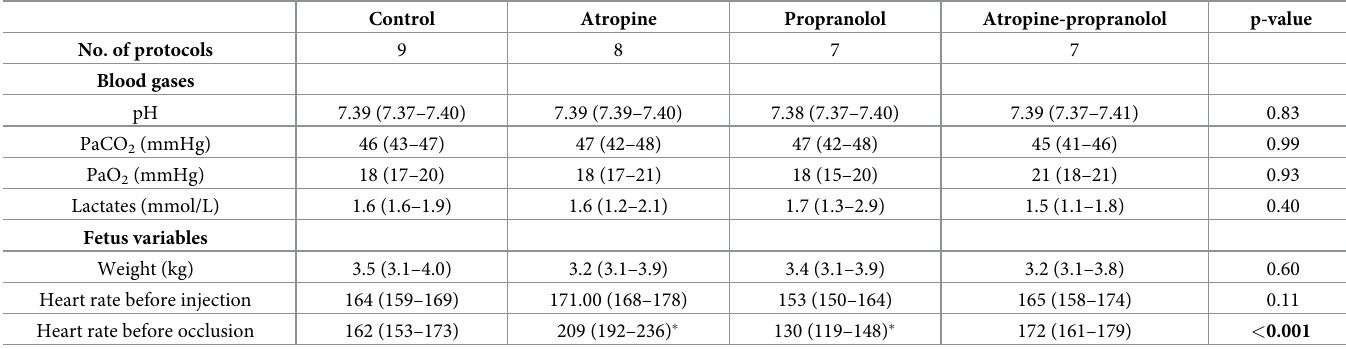
Table 1. Fetal arterial blood gases and fetal hemodynamic variables before occlusion.